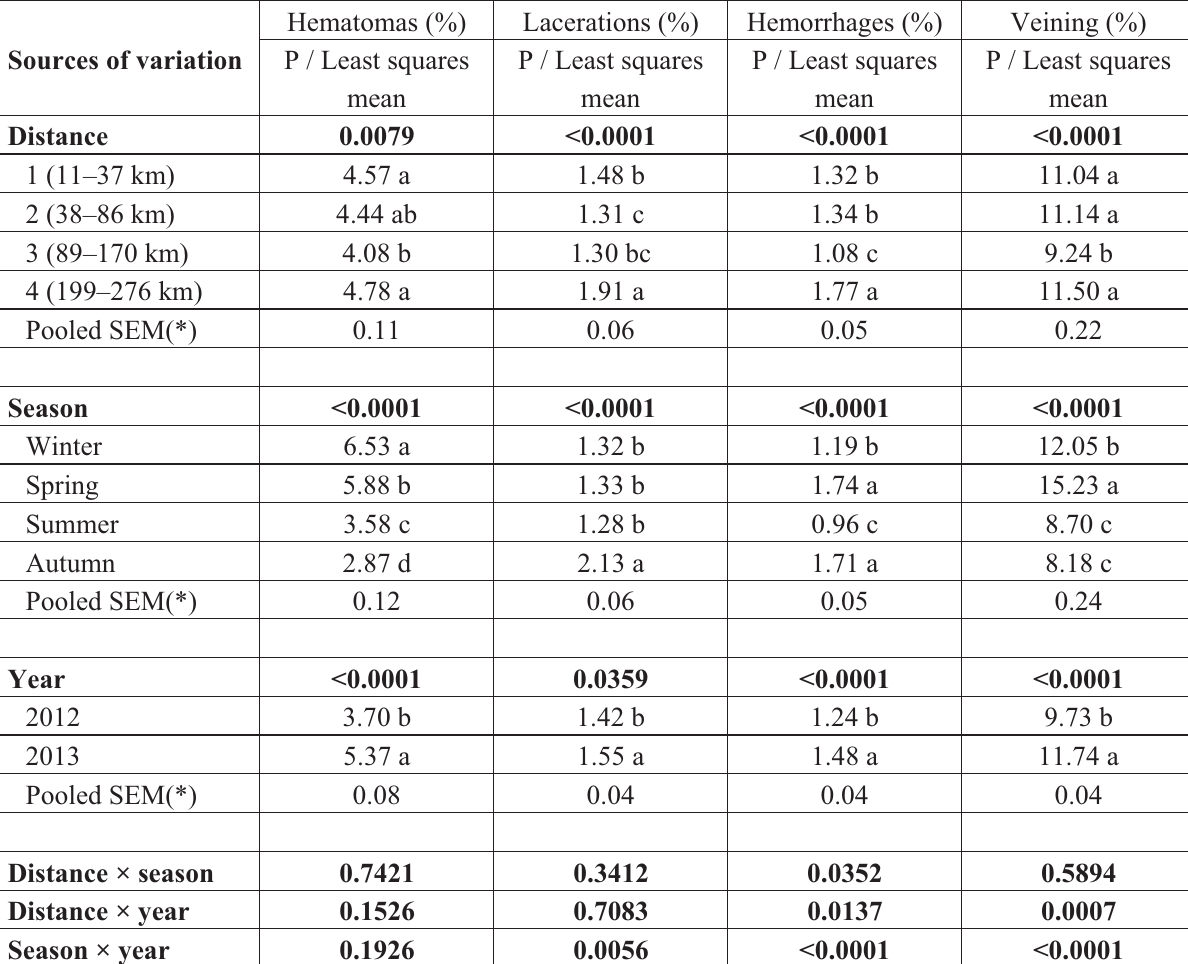
Table 4. Results of variance analysis and least-squares means of defects incidence by sources of